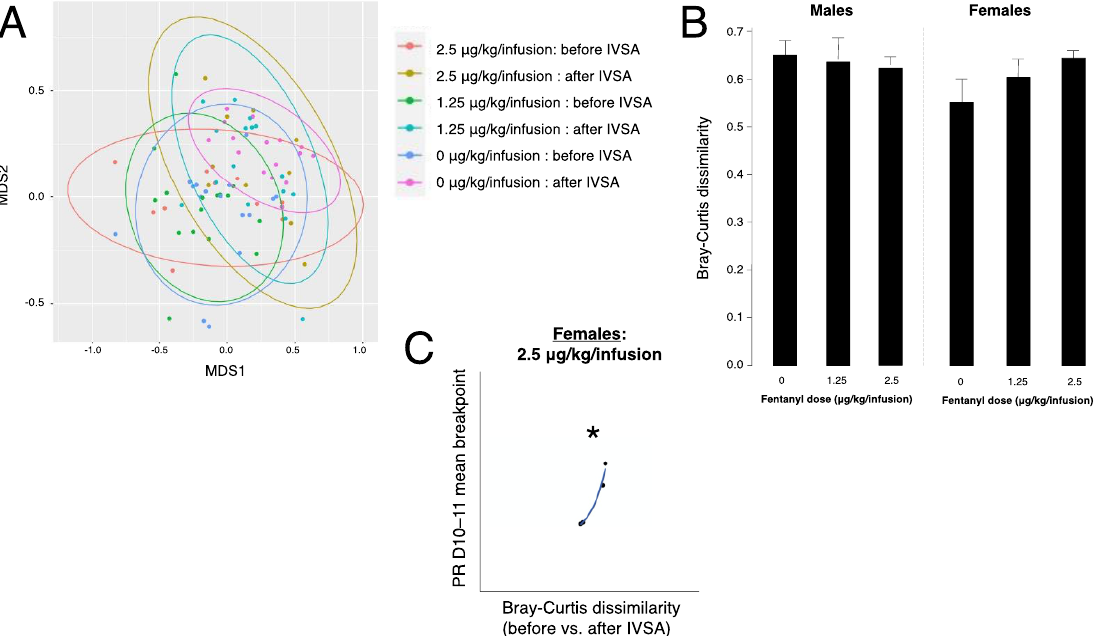
Figure 4. Beta diversity of gut bacteria before and after IVSA. ( A ) Non-metric multidimensional scaling (NMDS) ordination of gut microbiota communities before and after fentanyl IVSA at 0, 1.25, and 2.5 µ g/kg/infusion. ( B ) Bray-Curtis dissimilarity values extracted from distance matrix comparing before and after IVSA within each animal at 0, 1.25, and 2.5 µ g/kg/infusion in males and females (error bars represent S.E.M., n = 4–9/group). ( C ) Correlation plot of Bray–Curtis dissimilarity vs. progressive ratio (PR) mean breakpoint on days (D) 10–11 in females at 2.5 µ g/kg/infusion (* p < 0.05, n =